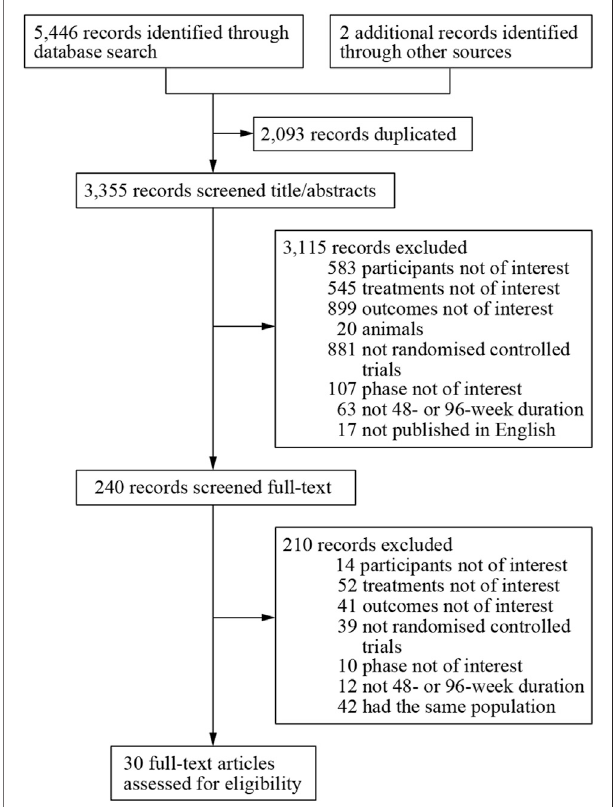
FIGURE 1 | Flow chart of study